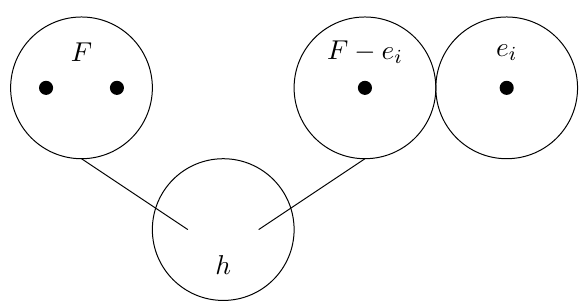
Figure 2 . The geometry of V 2 . The P 1 ’s are labeled by their classes in V 2 . The dots are the intersection points of E ∈ O ( − K ) with the fibral P 1 ’s in different